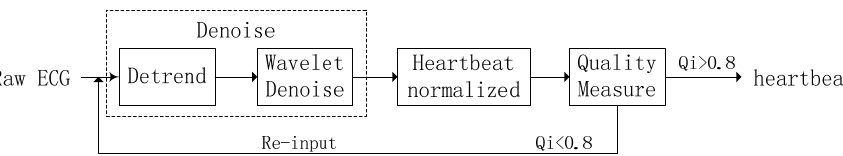
Figure 7. Block diagram of proposed processing